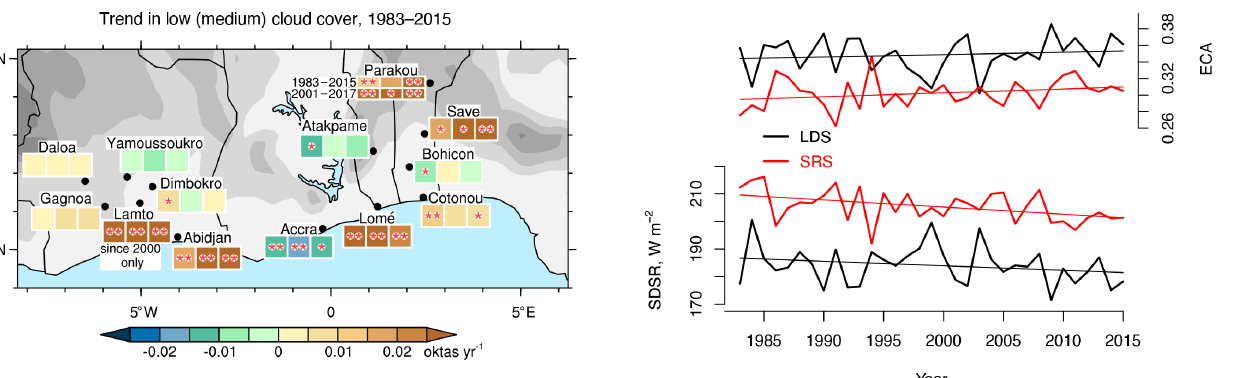
Figure 11. Time series of cloud cover and radiation. Time series from 1983–2015 and simple linear-regression lines show the tempo- ral evolution of the CM SAF satellite data of effective cloud albedo (ECA) and surface downwelling shortwave radiation (SDSR). Data are shown for the LDS (black) and the SRS (red) and are spatially averaged over the entire study region (see Fig.